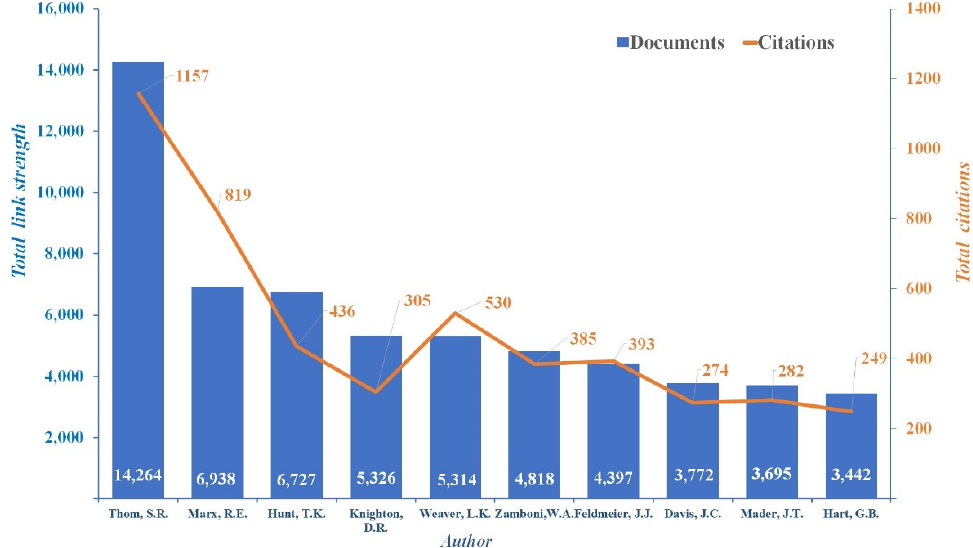
Figure 6. Bibliometric analysis of the most active co-authors’ relationships.